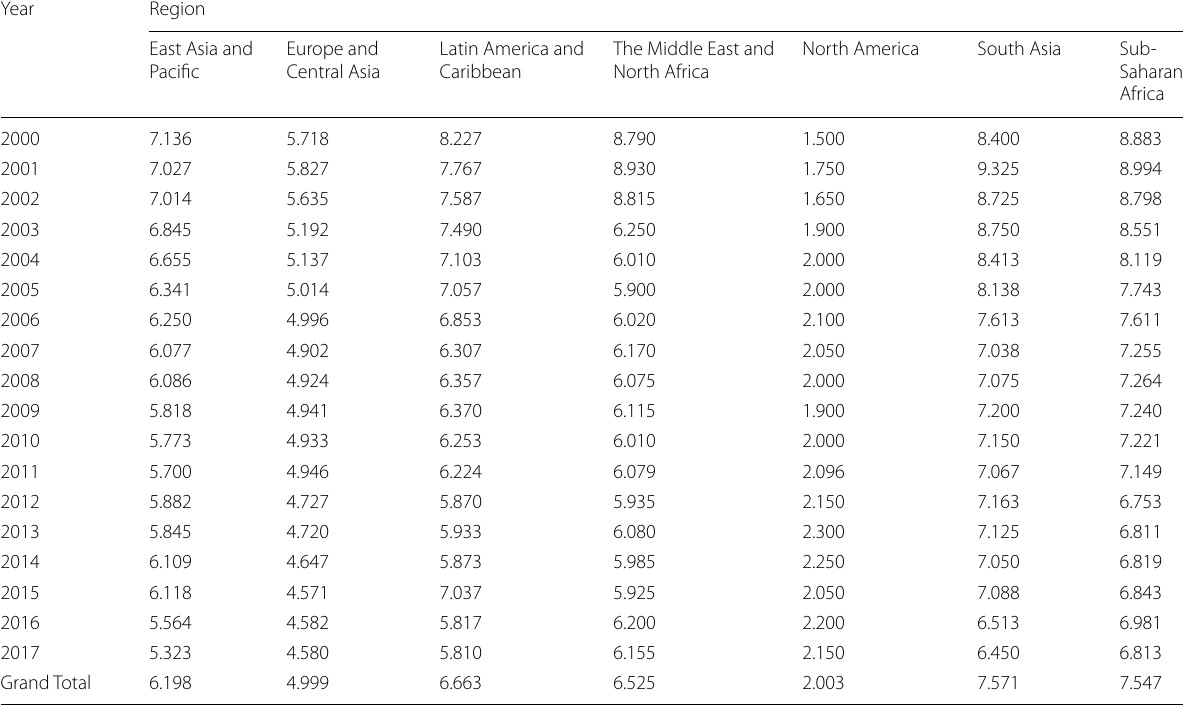
Table 3 CI scores across